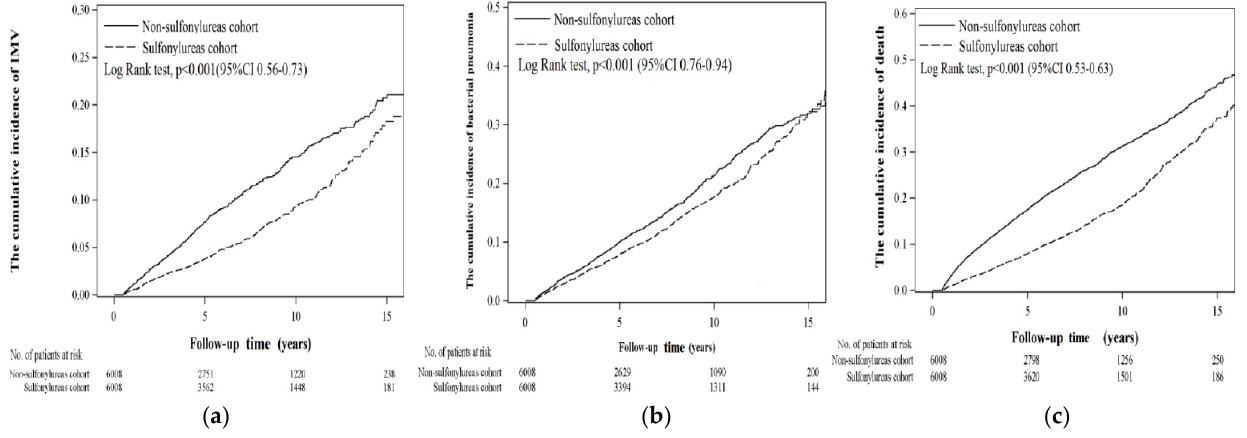
Figure 3. Cumulative incidence of ( a ) invasive mechanical ventilation (IMV), ( b ) bacterial pneumonia, and ( c ) death in sulfonylurea and non-sulfonylurea cohorts.